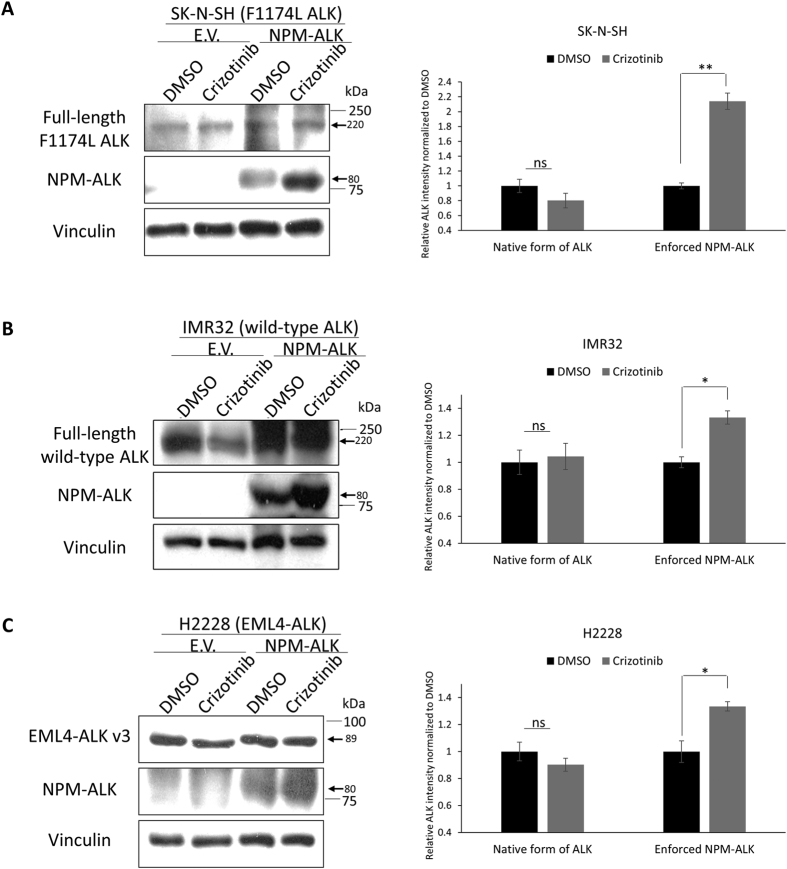
Differential sensitivity to Crizotinib, through physical binding, is specific to ALK structure.(A–C) Enforced expression of NPM-ALK into Crizotinib-resistant cell lines (i.e. SK-N-SH, IMR32, and H2228) were treated with 50 nM Crizotinib for 6 hours and showed stabilization of NPM-ALK but not the native ALK. CETSA assay was performed at 52 °C. Representative Western blots are shown on the left side and the densitometry quantification data from 3 independent experiments are shown on the right side. Data are presented as mean ± SD. *P < 0.05, **P < 0.01, Student’s t test.